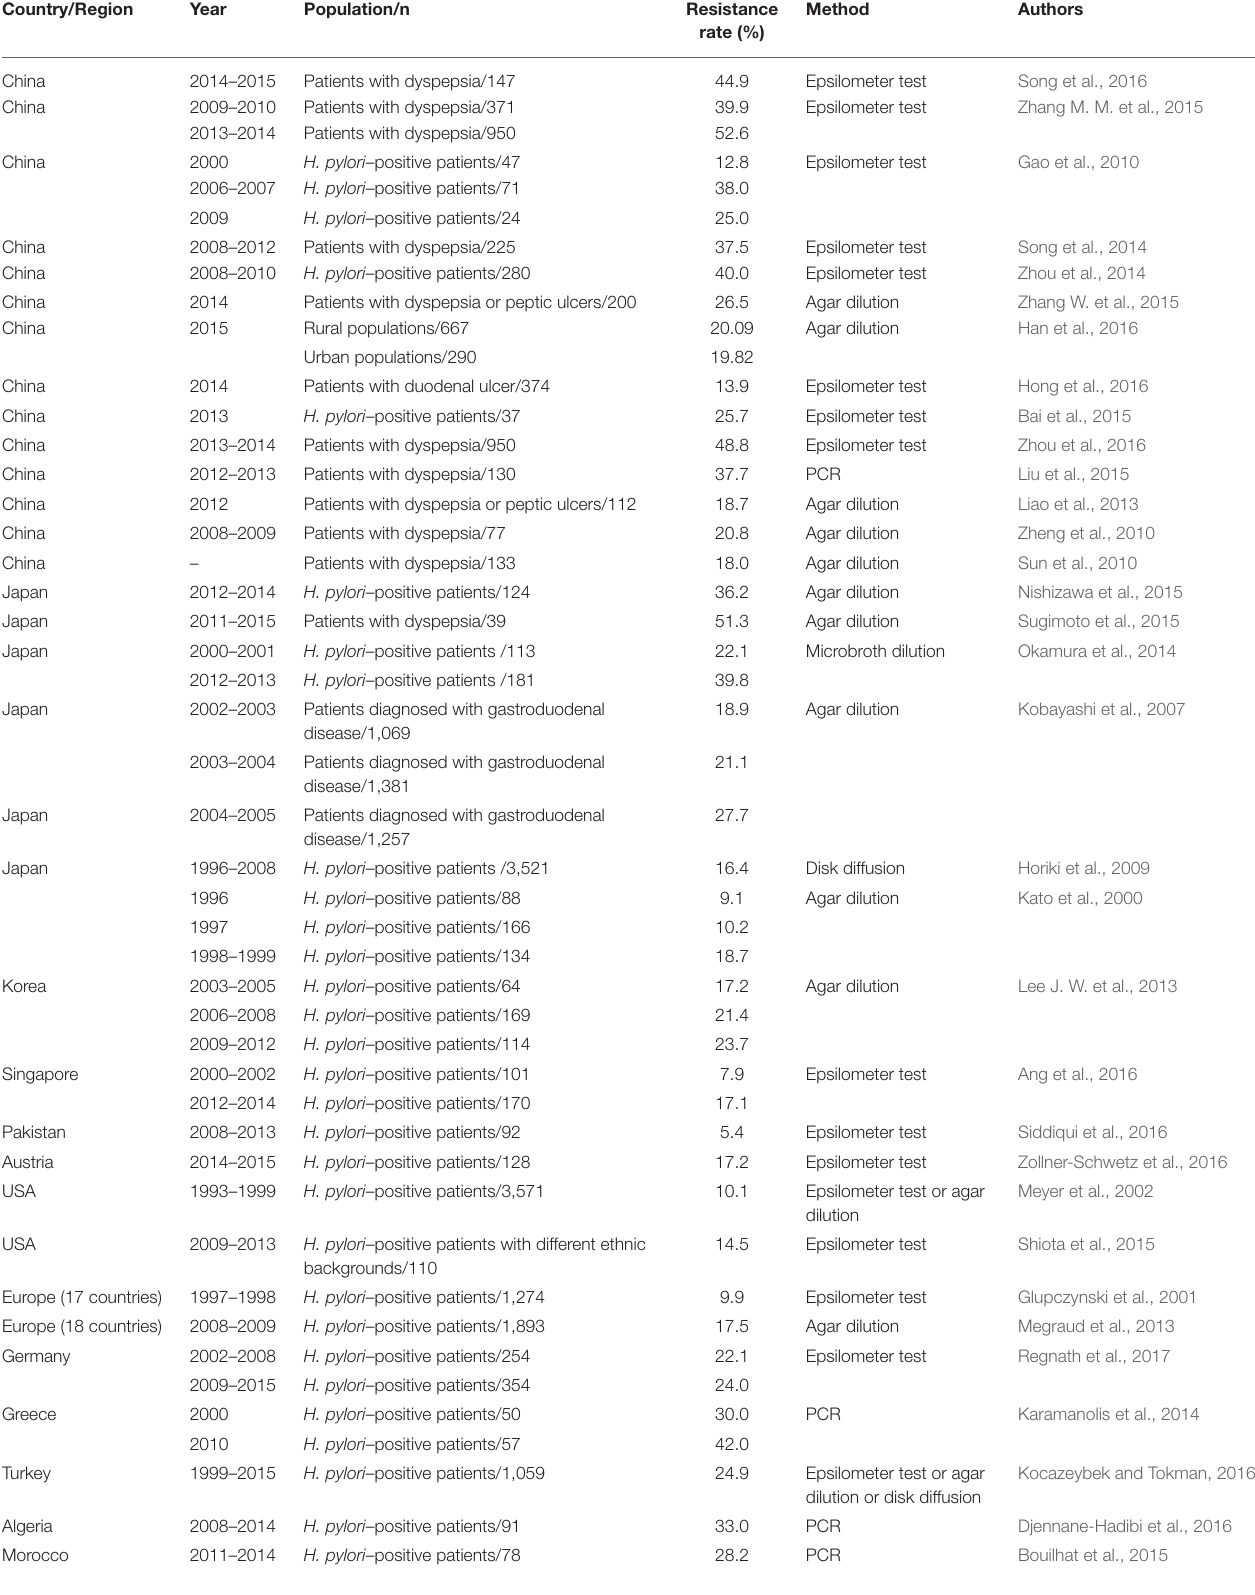
TABLE 2 | Primary H. pylori clarithromycin resistance.